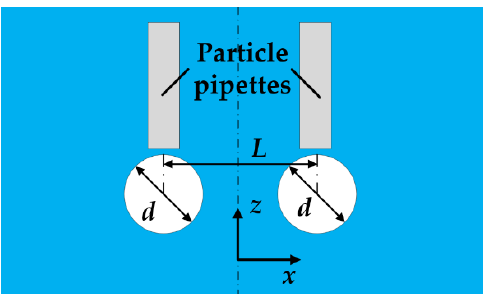
Figure 7. Schematic of the sedimentation of two side-by-side particles.